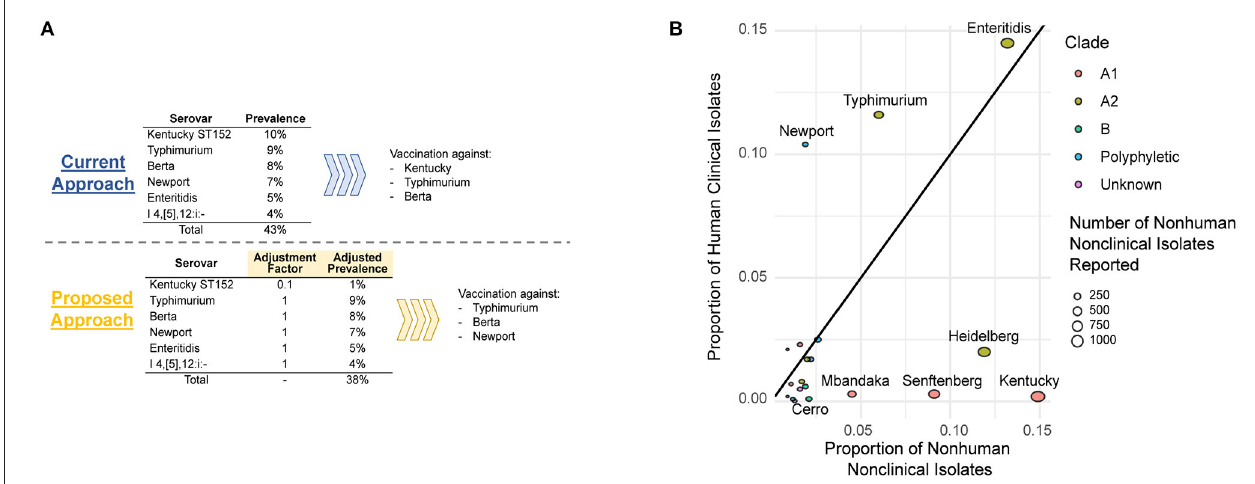
FIGURE 1 | (A) A hypothetical example of how adjustment factors could be used to inform intervention strategies to decrease prevalence of NTS serovars of public health significance in chicken flocks. (B) Over- and underrepresentation of human and animal isolates based on data from Centers for Disease Control and Prevention’s 2012 National Salmonella Surveillance Annual Report (National Salmonella Surveillance, 2014). Bubbles are colored based on the phylogenetic clade of the serovar as determined previously (Worley et al., 2018); serovars that are known to be polyphyletic are shown in